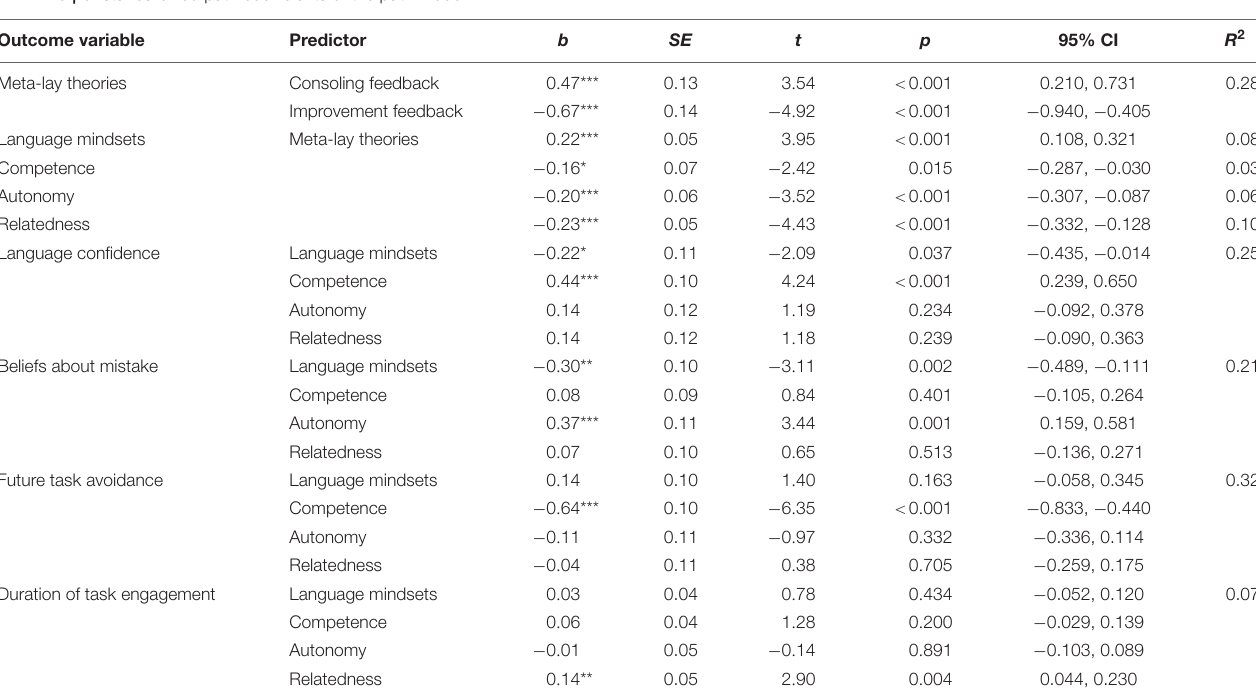
FIGURE 3 | Results of the final path model. Numbers are standardized path coefficients. The solid dark lines represent significant paths ( p < 0.05); the dashed gray lines represent non-significant paths. TABLE 3 | Unstandardized path coefficients of the path